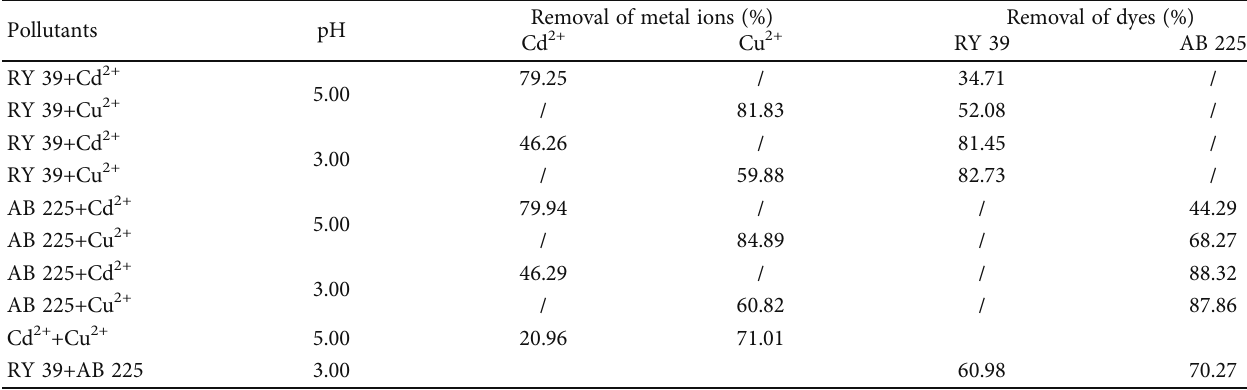
Table 7: Competitive adsorption from binary mixtures onto